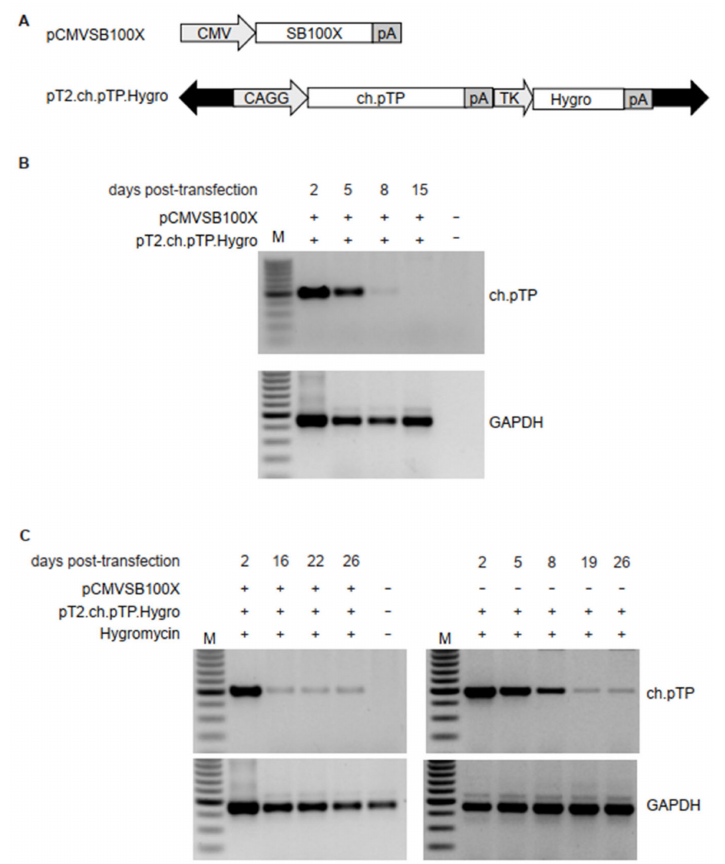
Figure 1. Transposition of ch.pTP in HEK293 cells. ( A ) Schematic outline of the plasmids carrying transposon or transposase. pCMVSB100X carries the SB100X transposase coding sequence under the control of cytomegalovirus (CMV) promoter. The pT2.ch.pTP.Hygro transposon plasmid carries the expression cassettes for ch.pTP, under the control of the hybrid CAGGS promoter, and a second expression cassette for the Hygromycin resistance gene (Hygro), driven by Herpes Simplex Virus Thymidine Kinase (TK) promoter. Black arrows indicate T2 IR. pA, polyadenylation signal. ( B ) PCR amplification of a fragment (489 bp) of ch.pTP and, as control, GAPDH in the genomic DNA from HEK293 cells co-transfected with pCMVSB100X and pT2.ch.pTP.Hygro plasmids. ( C ) PCR amplifica- tion of a fragment (489 bp) of ch.pTP and, as control, GAPDH in the genomic DNA from HEK293 cells transfected with pT2.ch.pTP.Hygro plasmid in presence (left panel) or absence (right panel) of pCMVSB100X and selected with Hygromycin. M, 100 bp molecular weight